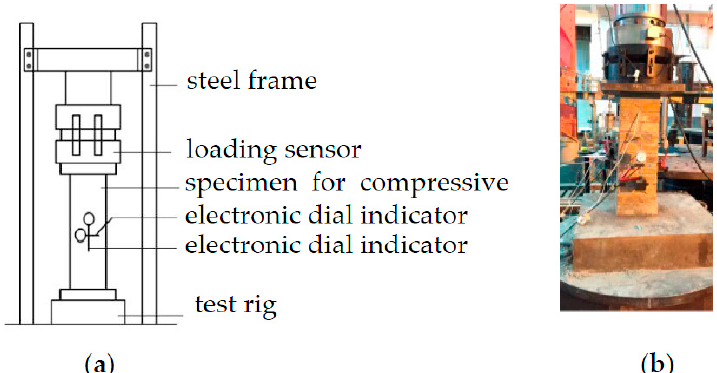
Figure 4. Loading imposed: ( a ) loading device; and ( b ) test scene.